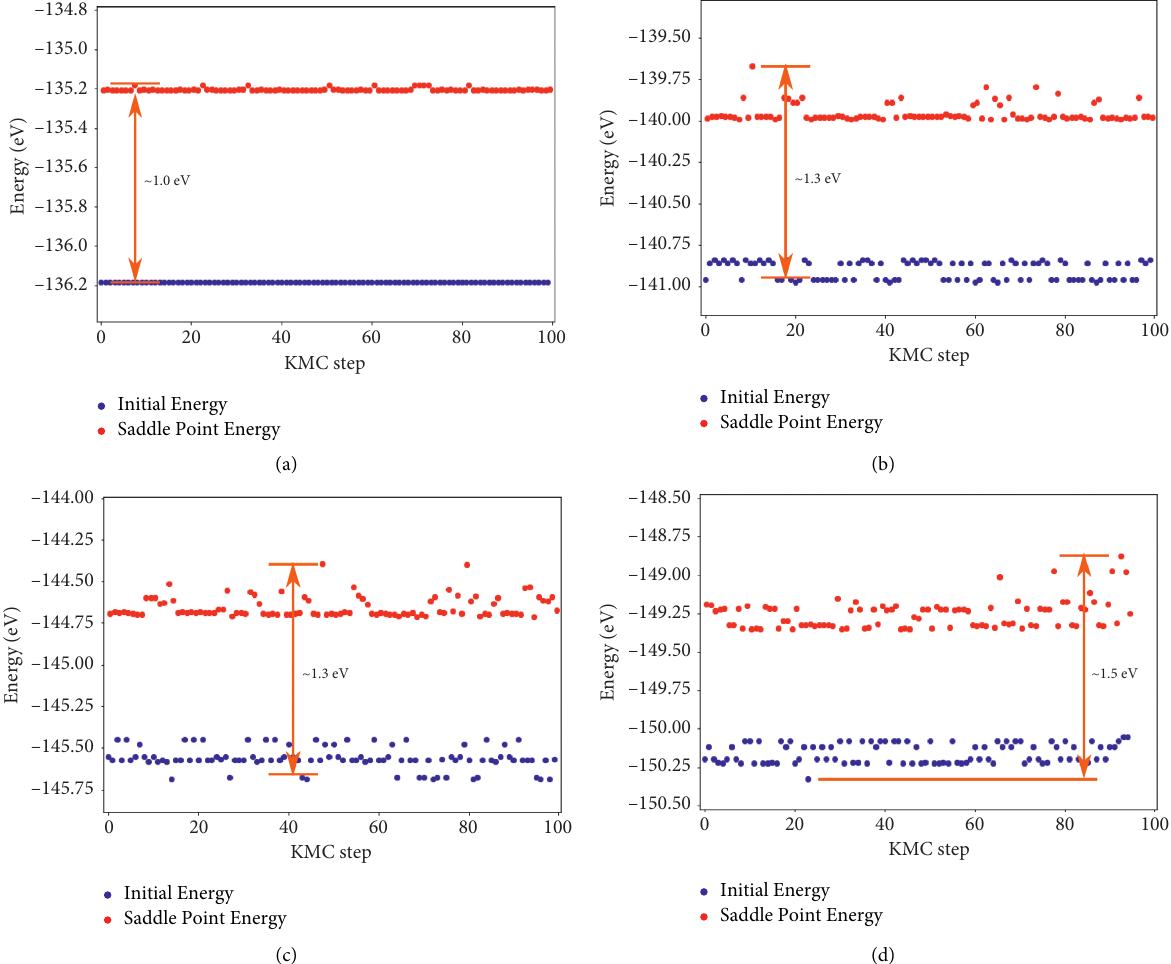
Figure 3: The energy profiles for the initial energies and the energies of the saddle points along the KMC steps of (a) pure Ni, (b) 3.22 mol% Re, (c) 6.44mol% Re, and (d) 9.66mol% Re throughout KMC steps.